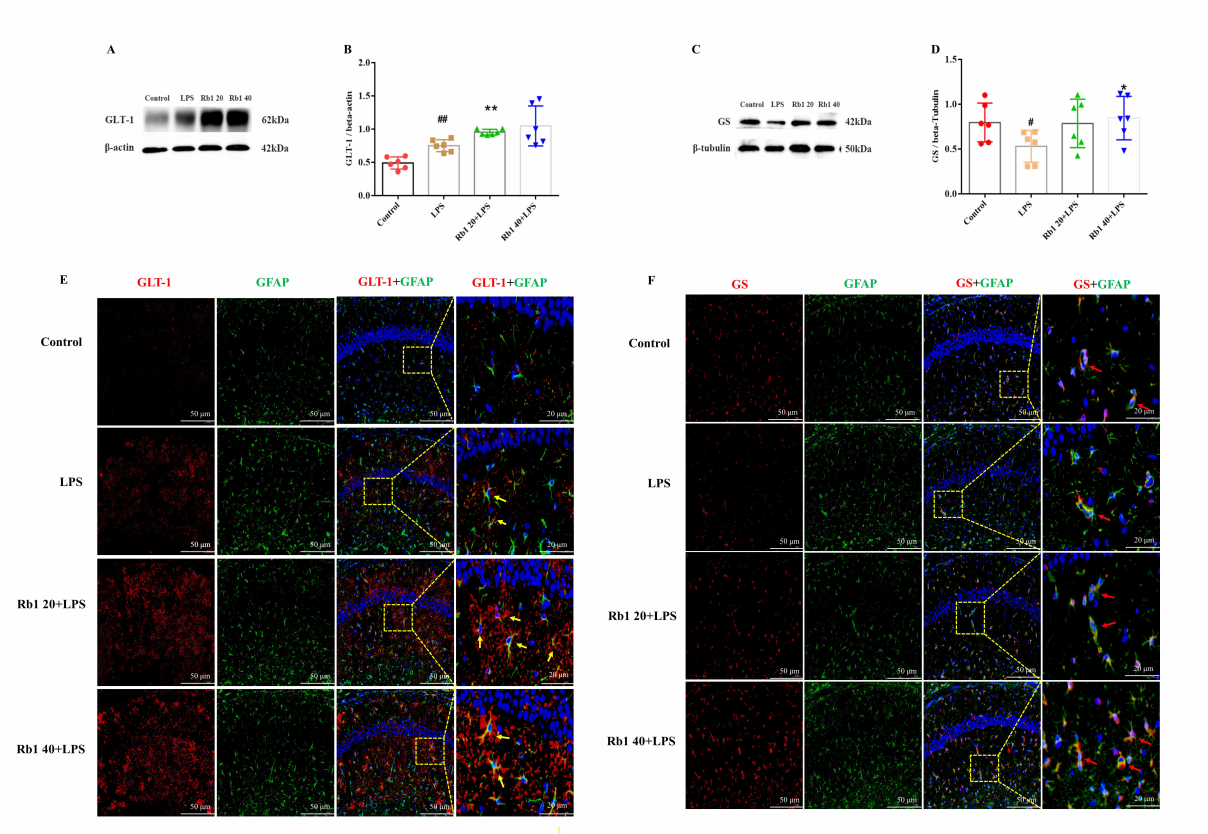
Fig. 6. Rb1 upregulated the expression of GLT-1 and GS in LPS mice. Western Blot and immunostaining were performed 24 h after LPS i.p. injection. Expressions of GLT-1 and GS in the brain were evaluated by Western blot analysis (A,C). The quantification of GLT-1 and GS were normalized by the expression of β -actin (B,D). Dual immunofluorescence staining with GFAP and GLT-1 or GS in the CA1 region of the hippocampus (E,F). GLT-1 and GS (Red), GFAP (Green). GLT-1 was expressed in astrocytes (Yellow arrows), GS was expressed in astrocytes (Red arrows). Data are represented as mean ± SD (n = 3~6). # p < 0.05, ## p < 0.05 versus the control group; * p < 0.05, ** p < 0.01 versus the LPS